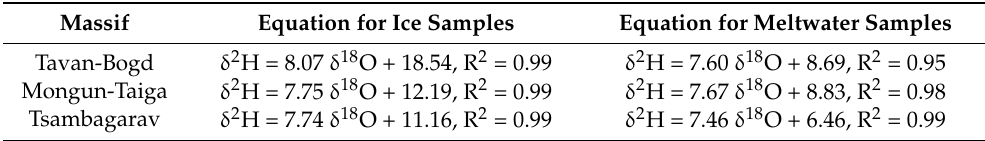
Table 4. δ 18 O- δ 2 H relations equations for ice and meltwater. Massif Equation for Ice Samples Equation for Meltwater Samples